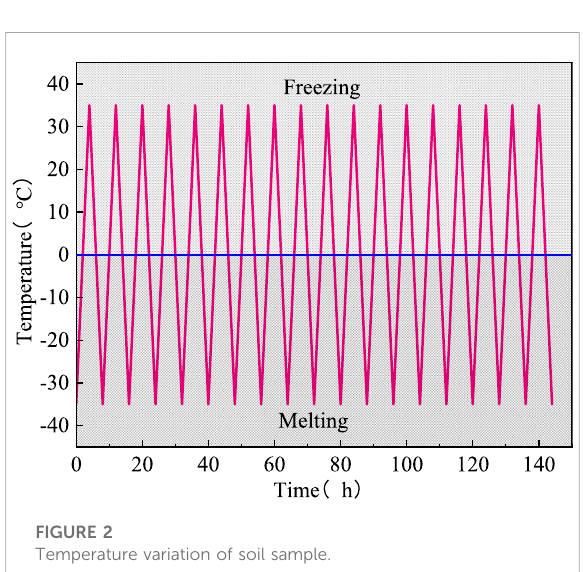
FIGURE 2 Temperature variation of soil